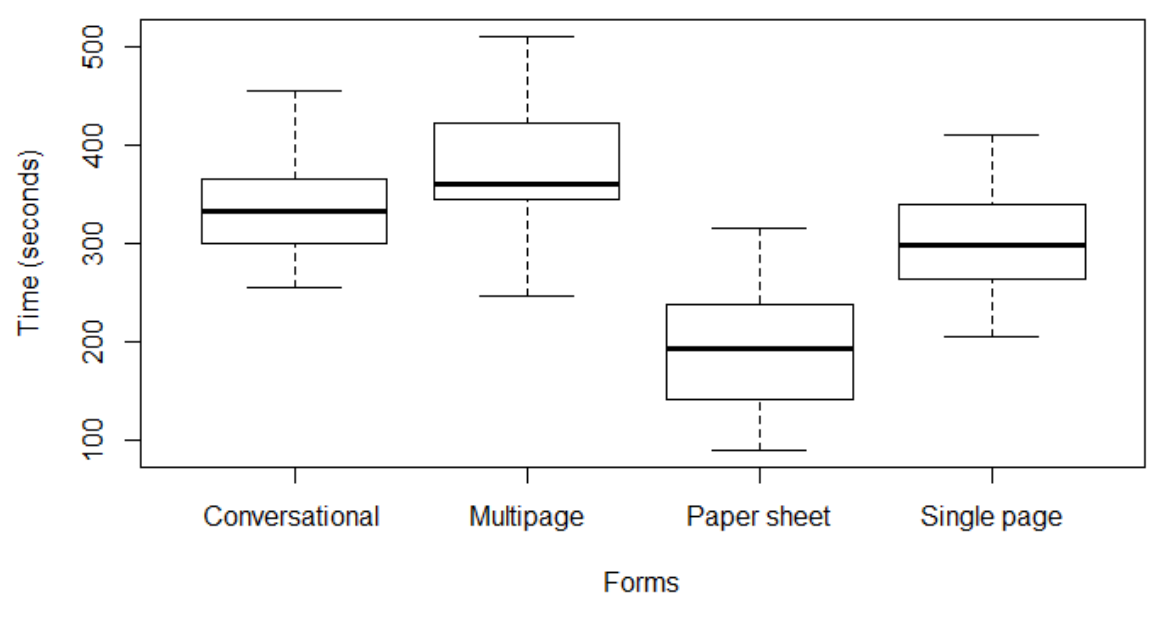
Figure 9. Boxplot for the average form completion time of each form. The primary percutaneous coronary intervention activator nurses took the least time for the paper form, as they are currently using this for primary percutaneous coronary intervention referrals. However, the research nurses who had no prior exposure to this paper form took almost as much time as the time activator nurses took to complete the digital forms (mean 224 seconds, SD 54 seconds vs mean 298, SD 60 seconds; P <.001).